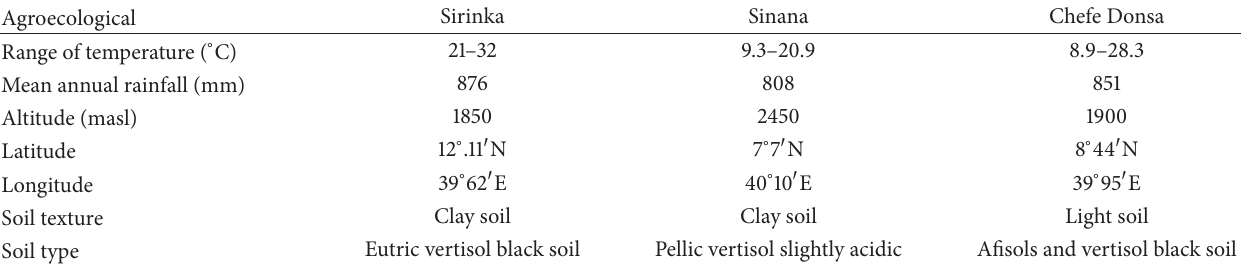
Table 1: Geographical, climatic, and soil features of the experimental sites.